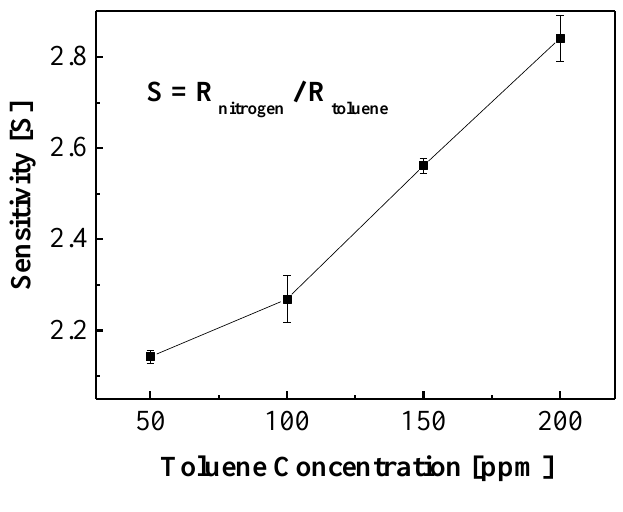
Figure 7. Characteristics of sensitivity with the toluene gas